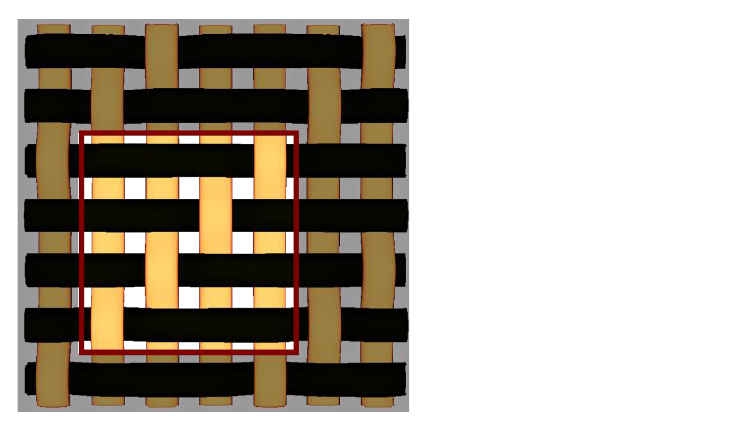
Figure 7. The RUC of satin 4/1/1 relative to a 7 × 7 yarns reference area.